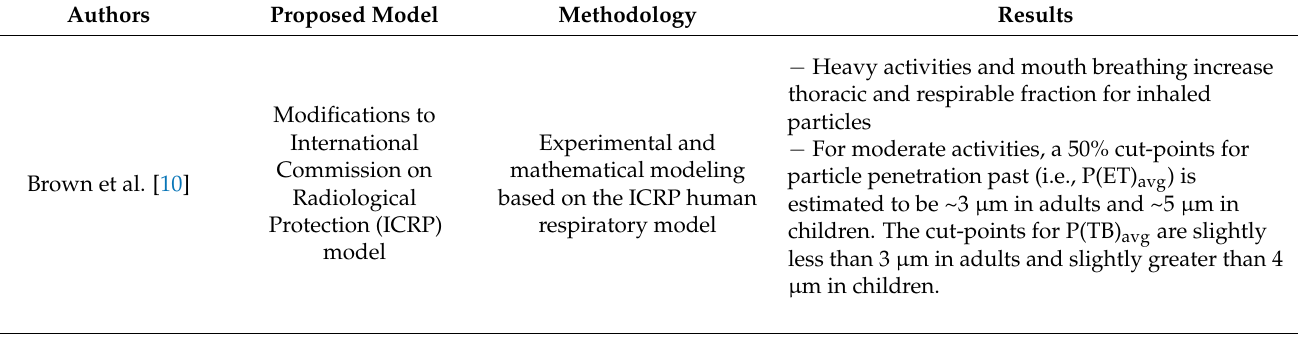
Table 1. A summary of recent lung deposition studies for respirable dust